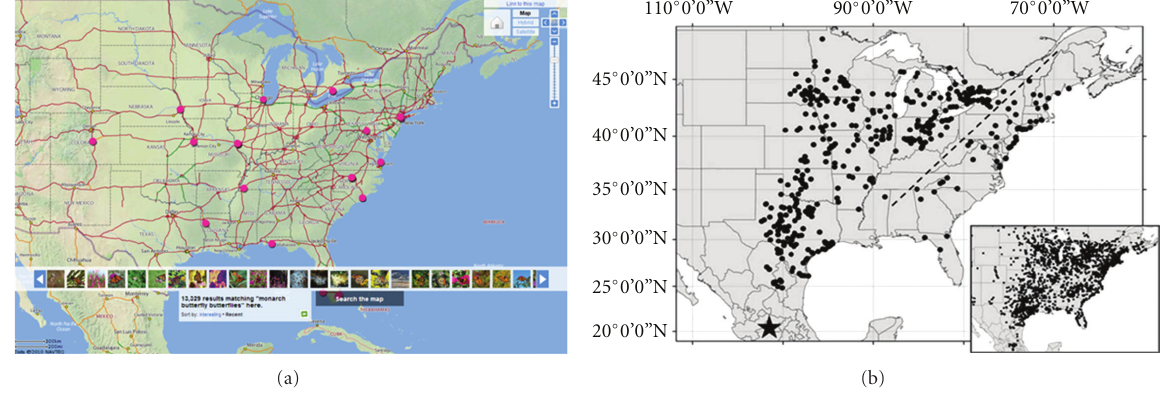
Figure 2: (a) Screenshot of Flickr map displaying 250 of 13,329 geo-tagged photos tagged with “monarch butterflies butterfly” on February 28th 2012. (b) Map of Journey North roost sightings from all years combined (2005–2007). Dashed line indicates division of central and eastern flyways in analysis. Roosts in Florida were not included in the analyses. Inset map shows the locations of all Journey North participants from 1997 to 2007. Star indicates location of Mexico overwintering sites [45]. Reproduced with kind permission of Springer Science and Business